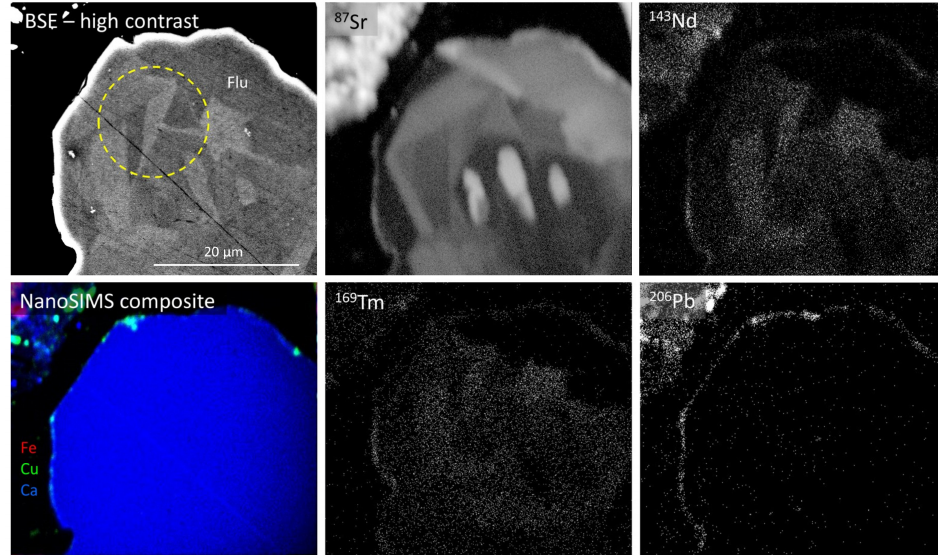
Figure 7. The high-contrast BSE (top left) and nanoSIMS images of sample 02CLD39 (coarse fluorite grain). The nanoSIMS composite image represents overlapping nanoSIMS maps of Fe (red), Cu (green), and Ca (blue). Sr 2 + commonly substitutes for Ca 2 + in fluorite, frequently resulting in intricate zoning patterns. REE, represented here by 143 Nd and 169 Tm, are associated somewhat negatively with Sr. Lead-206 is found only on the grain surface, likely as insoluble PbSO 4 . The dashed yellow circle represents the location and relative size of a single 15 µ m-diameter LA-ICP-MS spot